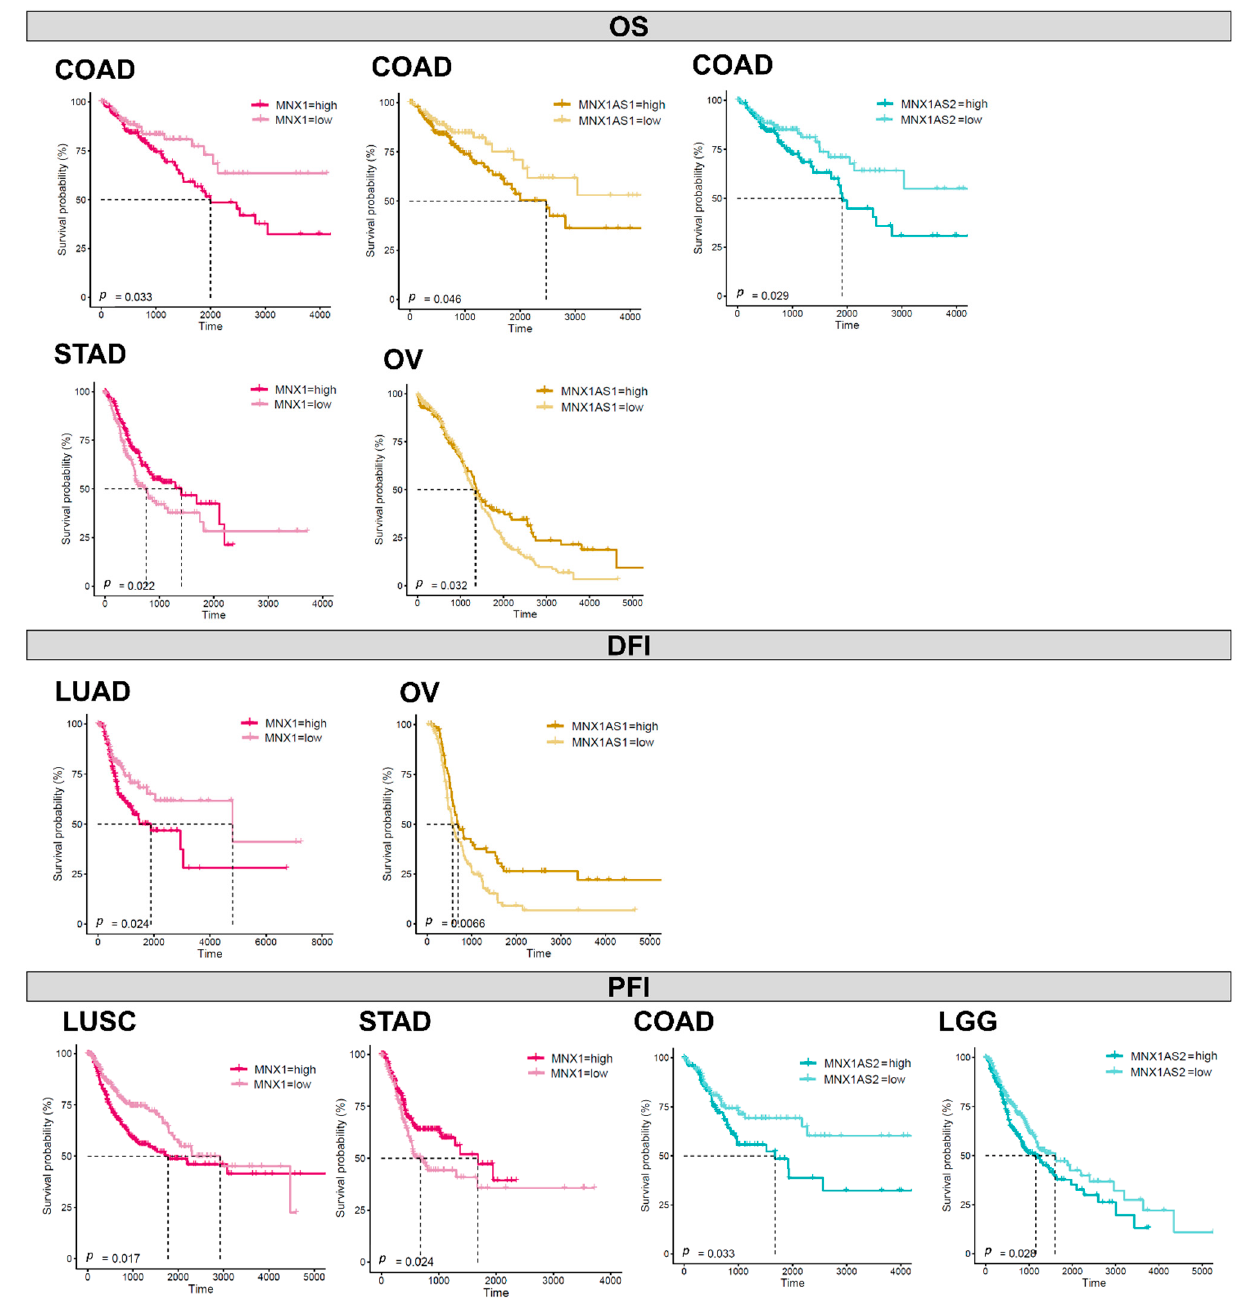
Figure 7. Prognostic evaluation of MNX1 , MNX1-AS1 , and MNX1-AS2 expressions. Kaplan–Meier plots of statistically significant associations between individual expressions of MNX1 , MNX1-AS1 , and MNX1-AS2 in OS, DFI, and PFI.